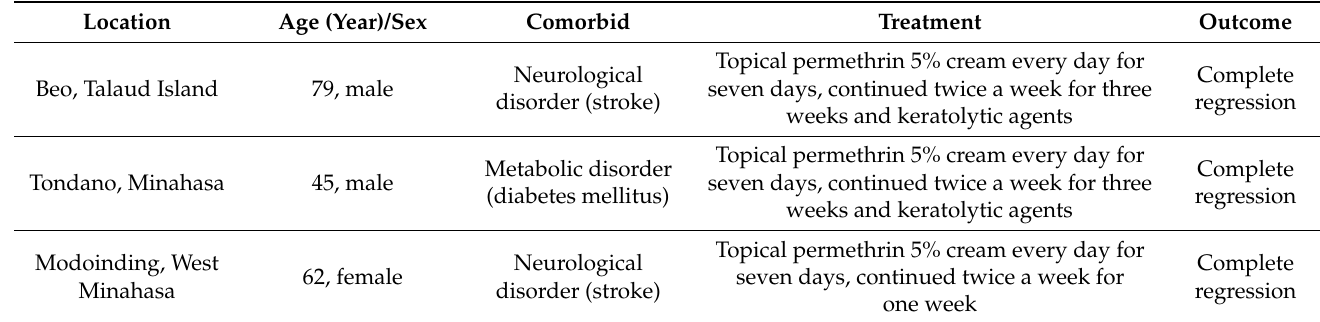
Table 1. Summary of findings from crusted scabies patients in North